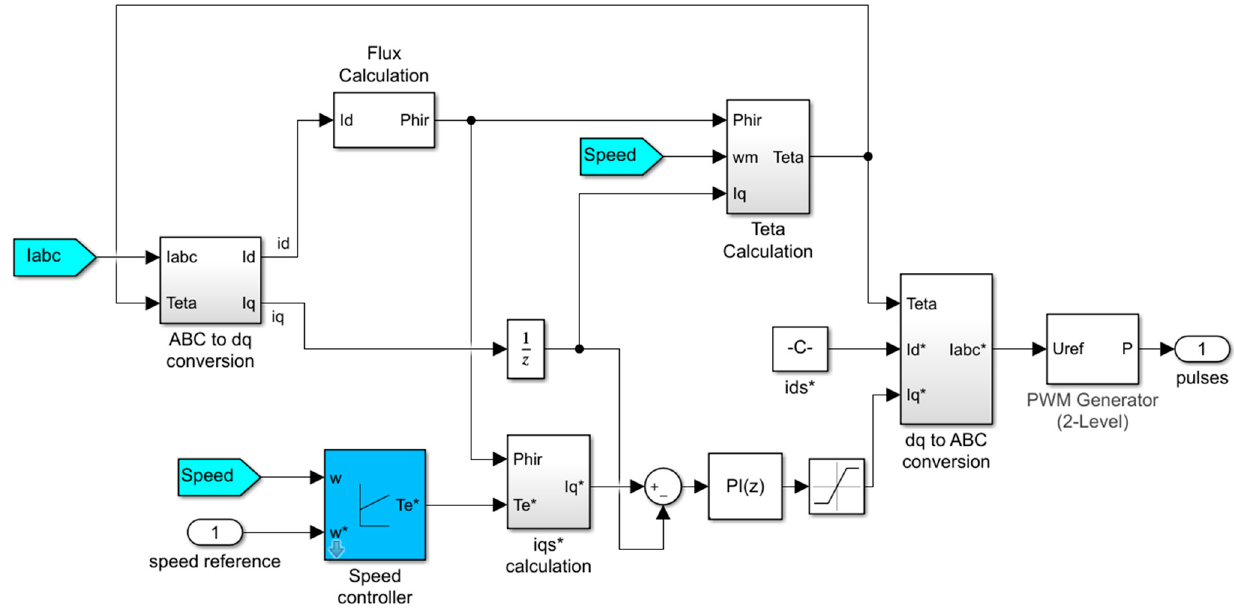
Figure 10. Indirect vector control block. Reproduced from [18] with permission from IEEE.